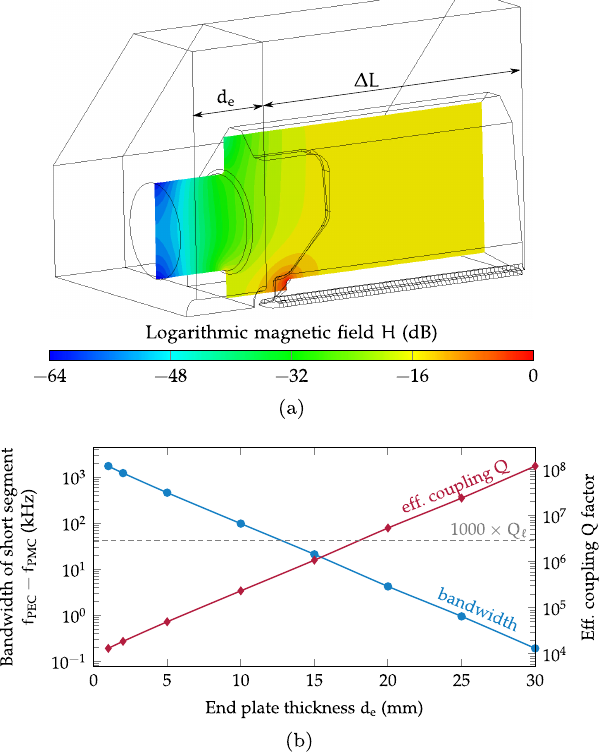
FIG. 20. Rf simulation of a Carbon-RFQ end segment (a) con- firming that an end plate thickness of 20 mm is sufficient to decouple the two cavities. Bandwidth f ated effective quality factor are shown in